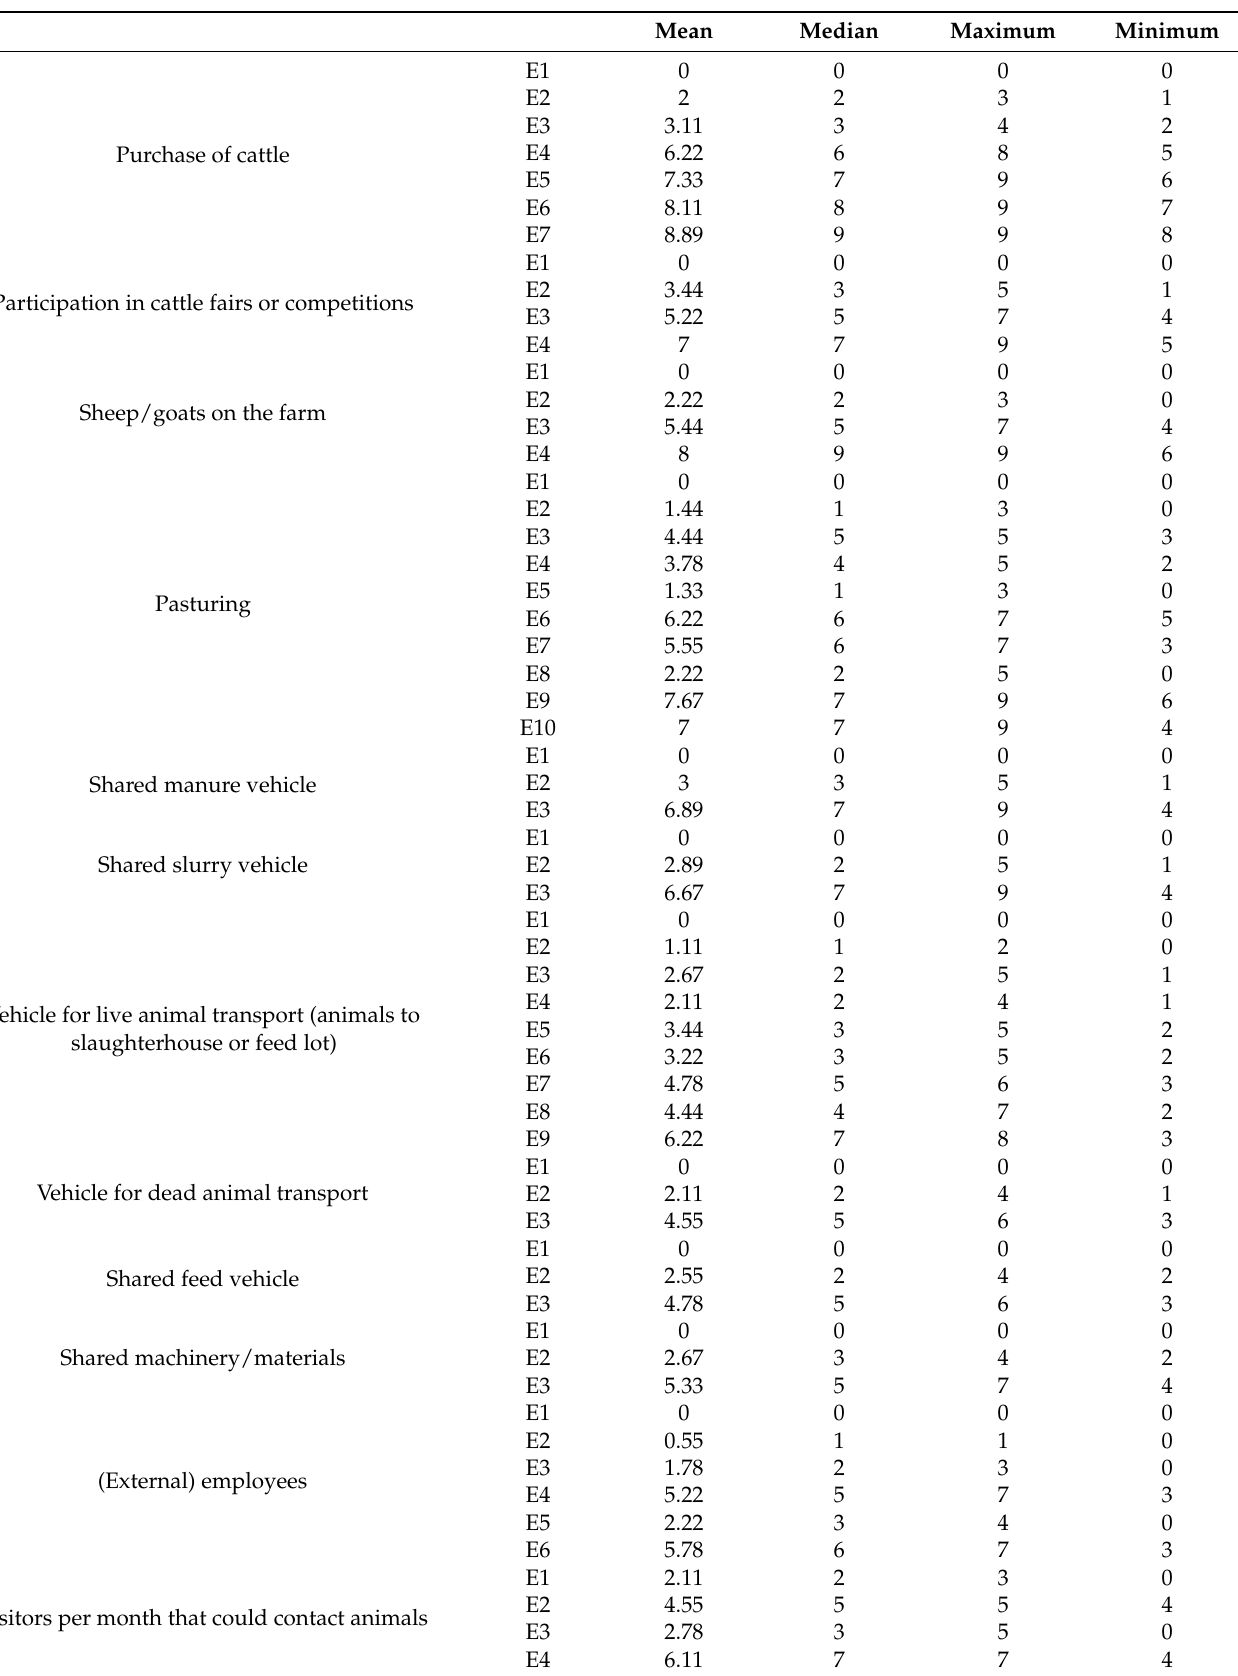
Table 1. Mean ordinal values for each event together with the, minimum, median and maximum values according to expert opinion. Mean Median Maximum Minimum E1